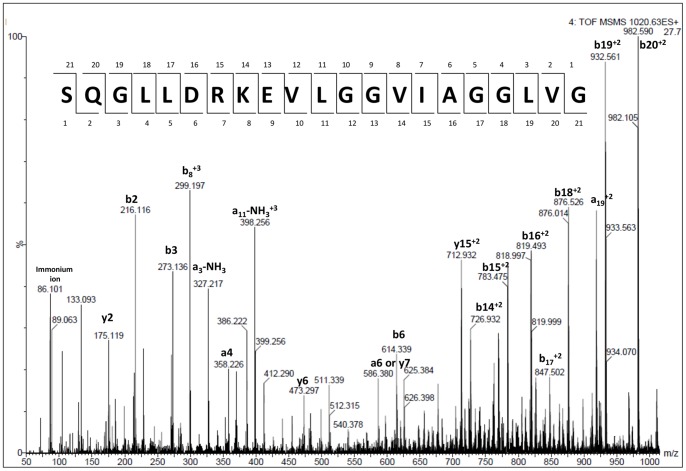
CID spectrum of a syndecan-1 peptide identified by LC-MS/MS.Endogenous peptides were identified by LC-MS/MS in the media after 24 h of PMA-treatment. The spectrum of syndecan-1 peptide (m/z 1019.5598, +2) was manually validated for b and y ion series.